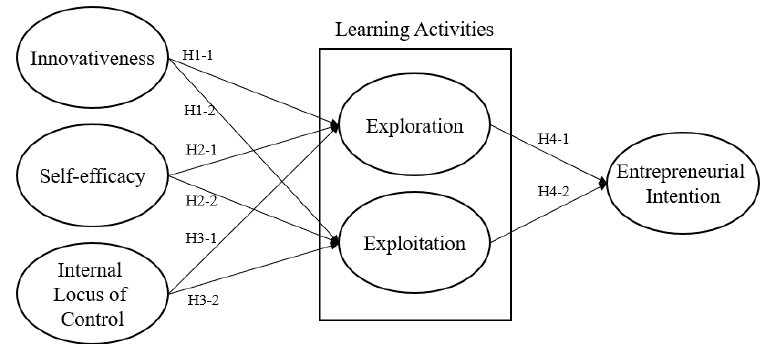
Figure 1. Research model.